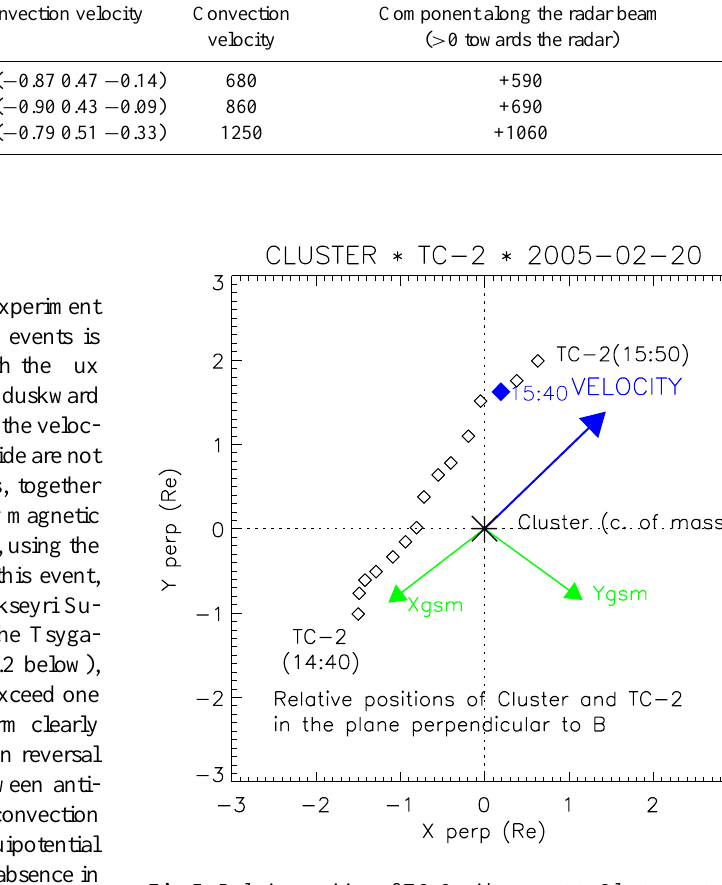
Fig. 5. Relative position of TC-2 with respect to Cluster centre of mass, in the plane perpendicular to the magnetic field for the 14:40– 15:50UT period. TC-2 position has been mapped at the Cluster al- titude. The X and Y axis of the GSM frame have been projected onto this plane (green arrows). The blue diamond shows the posi- tion of TC-2 at the time of Injection 3 ( ∼ 15:40UT). The blue arrow represents the velocity of Injection